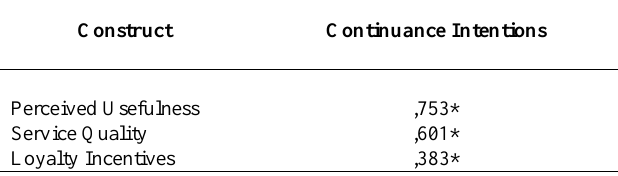
Table 3: Correlation matrix showing the relationship